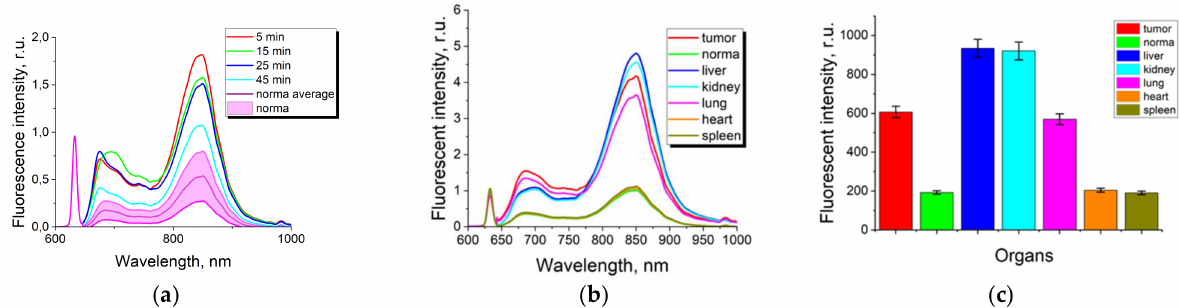
Figure 1. ( a ) Fluorescence spectra of ICG molecular solution in tumor xenografts at different times ( λ ex = 633 nm). The data obtained from the study of normal skin samples at all time points fluctuate in the range between two spectral curves (pink color); ( b ) fluorescence spectra of ICG molecular solution in excretory organs 5 min after intravenous administration ( λ ex = 633 nm); ( c ) integral dependence of the spectral curve of ICG molecular solution in tumor xenografts 5 min after intravenous administration ( λ ex = 633